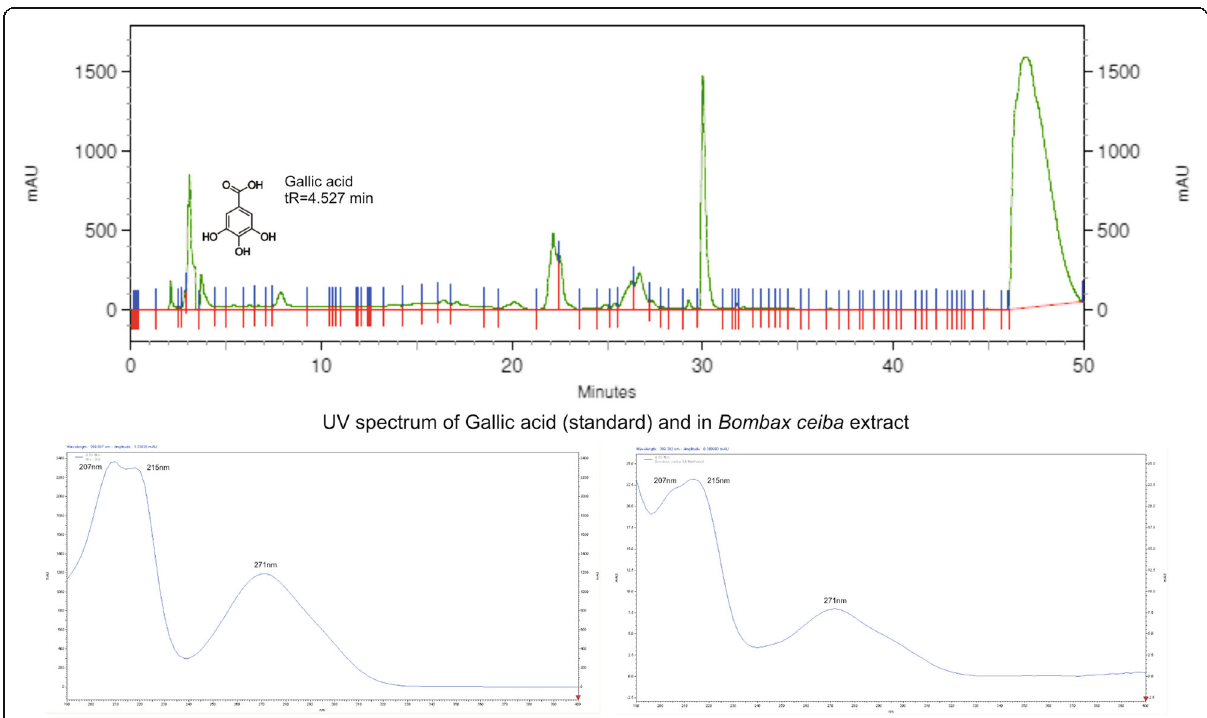
Fig. 1 HPLC chromatogram for the quantification of gallic acid in the methanolic extract of B. ceiba and UV spectrum of Gallic acid at 254 nm